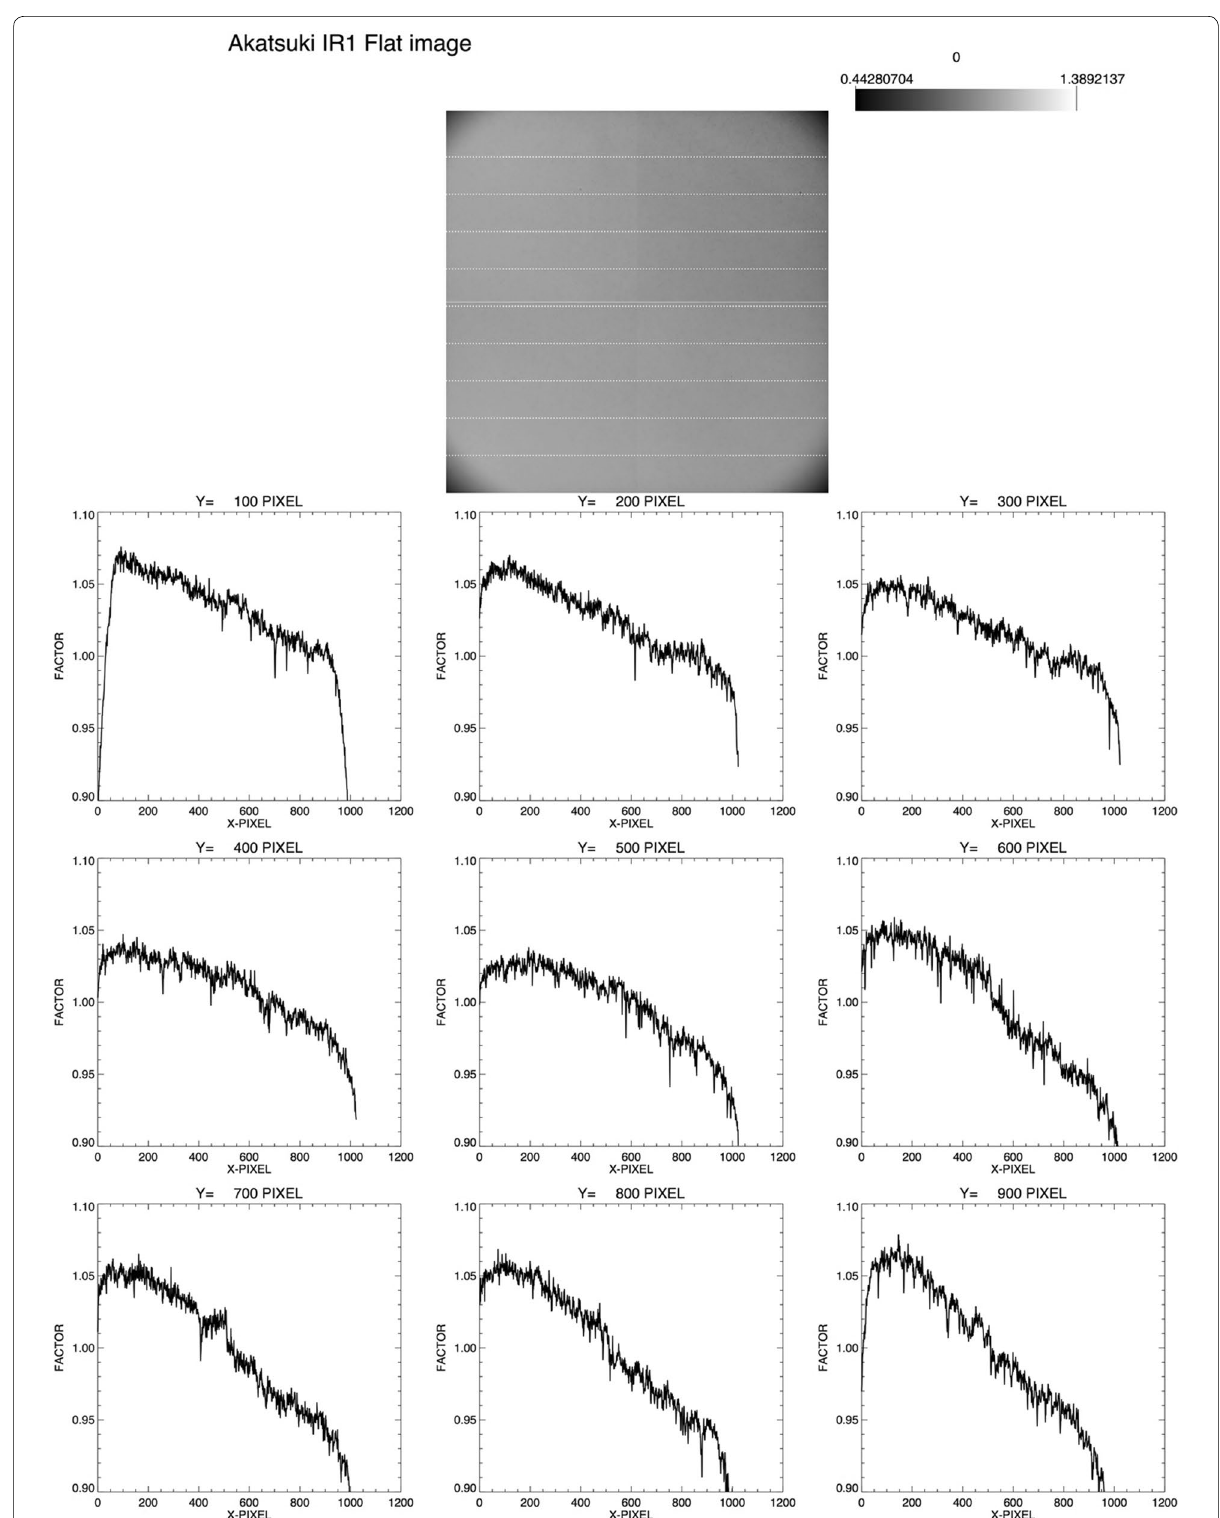
Fig. 10 Horizontal cross section of the flat field. The top image is the flat field in relative unit. The nine panels on the bottom show intensity along the horizontal dotted line (at y 100–900) in the top image. Factor indicates relative =